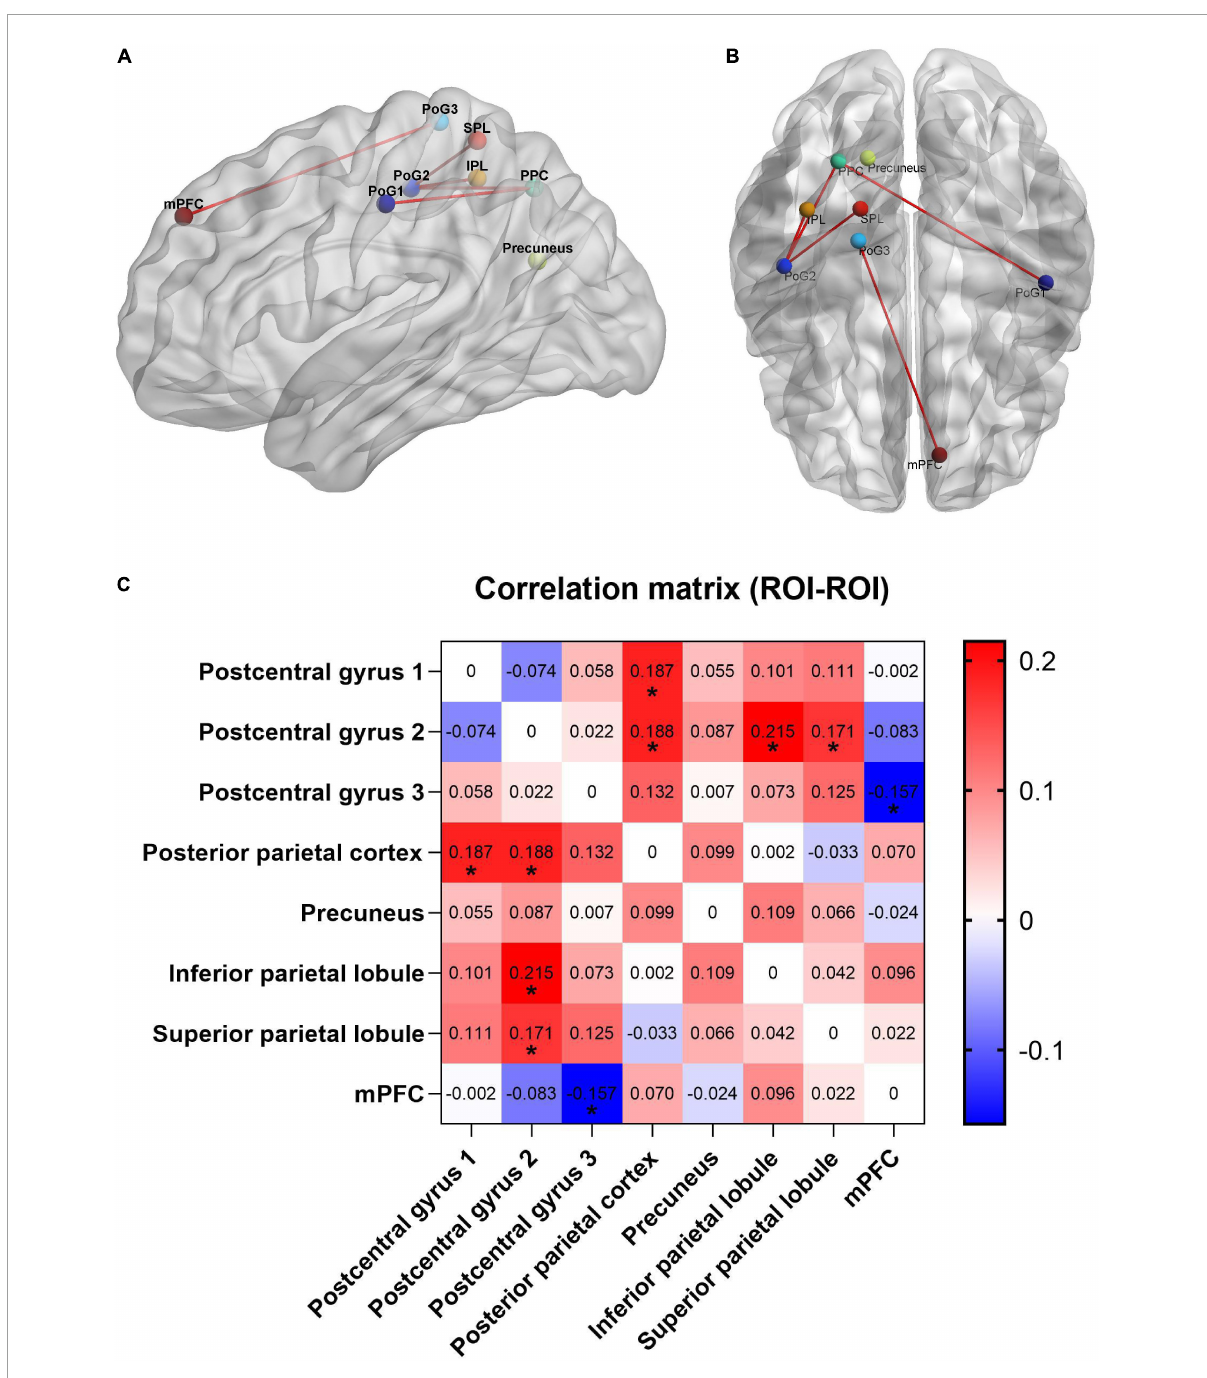
FIGURE1 Functional connectivity results with significant difference between groups. (A) Sagittal view. (B) Axial view. (C) Heat map of functional connectivity between groups from ROI–ROI analysis. The parameters represent the FC correlation coefficient. *Represents the functional connectivity of brain regions with significant correlation after FDR correction. PPC, posterior parietal cortex; PoG, postcentral gyrus; mPFC, medial prefrontal cortex; SPL, superior parietal lobule; IPL, inferior parietal lobule.